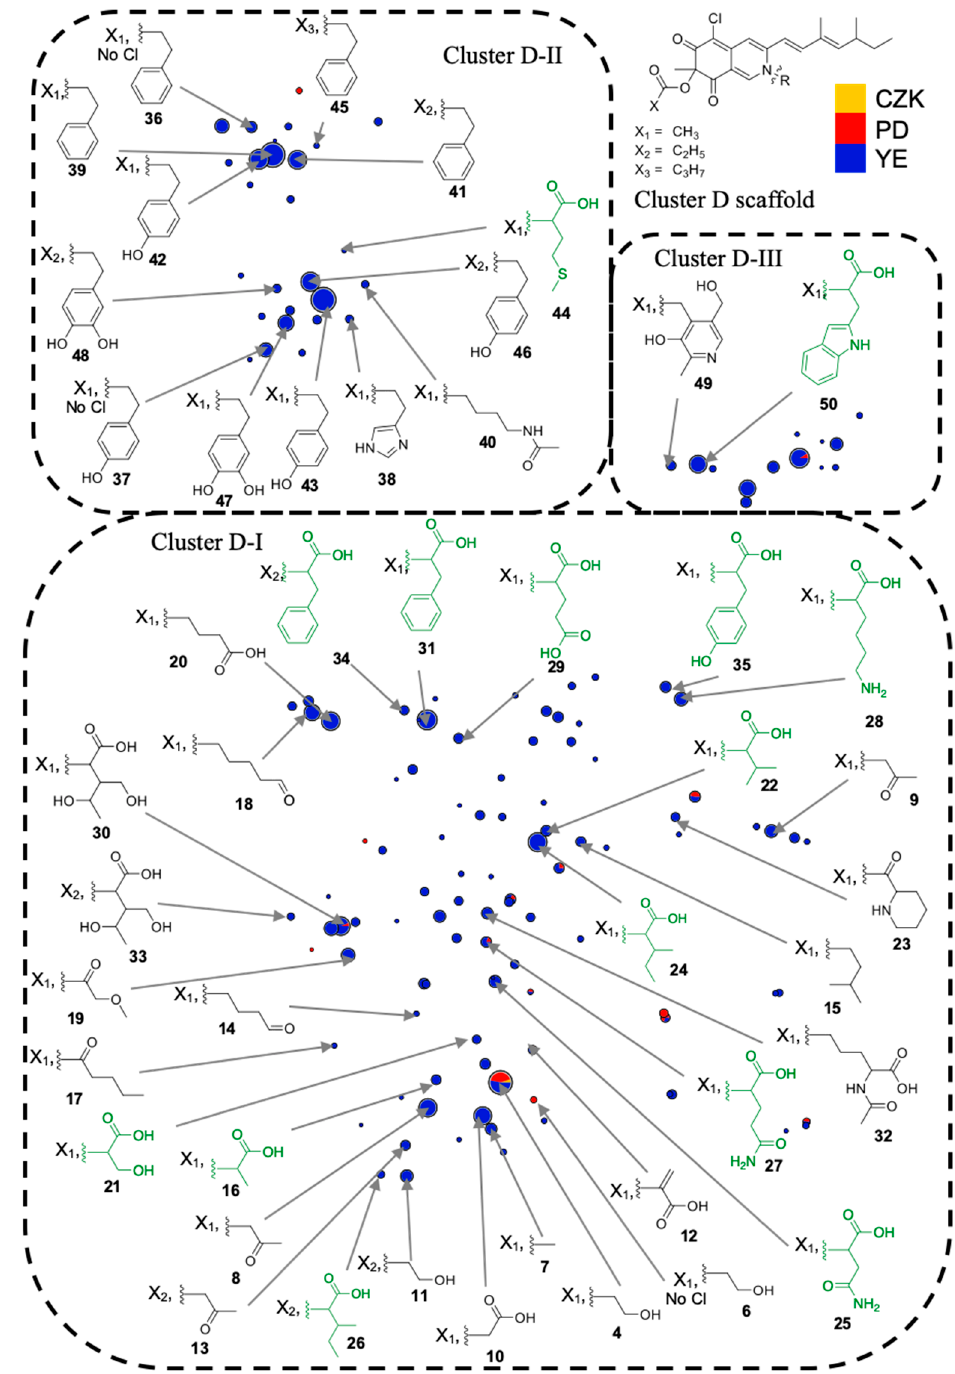
Figure 2. Annotation of the clusters D-I-, D-II and D-III with functionalized nitrogen chain structures integrated to the azaphilone scaffold, proposed from molecular network data and KEGG compound database. Acylation (X 1 ), proprionylation (X 2 ) and butylation (X 3 ) were identified using characteristic neutral losses [25]. “No Cl” means no chlorination moiety on the azaphilone scaffold; R amino acid groups are indicated in green.